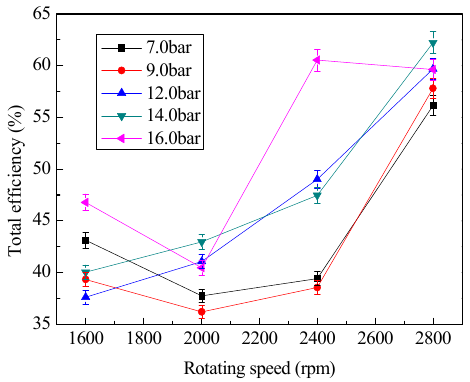
Figure 10. Total efficiency versus rotating speed.